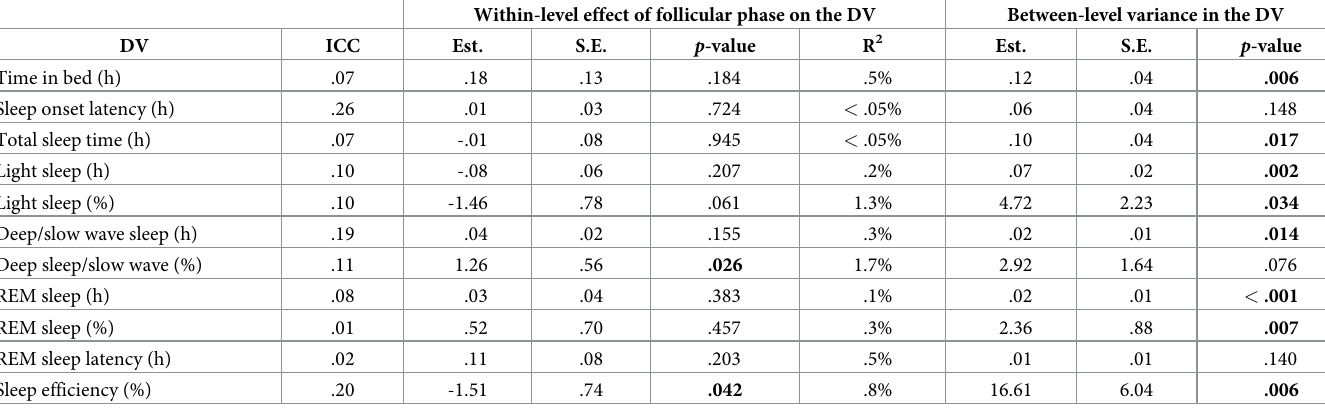
Table 5. Two-level random intercept regressions investigating the effect of follicular (= 1) vs. luteal (= 0) phase on sleep variables, based on menstrual cycles recorded in 15 female endurance